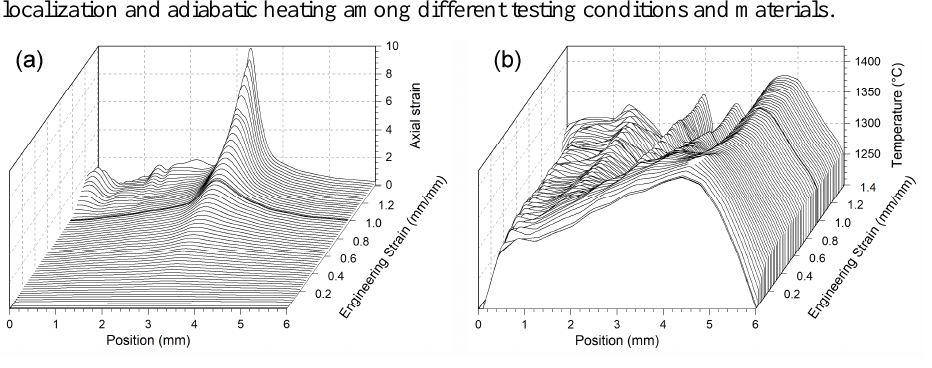
Fig. 3 : 3D waterfall plots of axial strain and temperature as a function of position along the gauge length of the specimen and global engineering strain of a commercially pure titanium specimen tested in tension at a strain rate of 1600 s − 1 and an initial temperature of approximately 1350 °C.